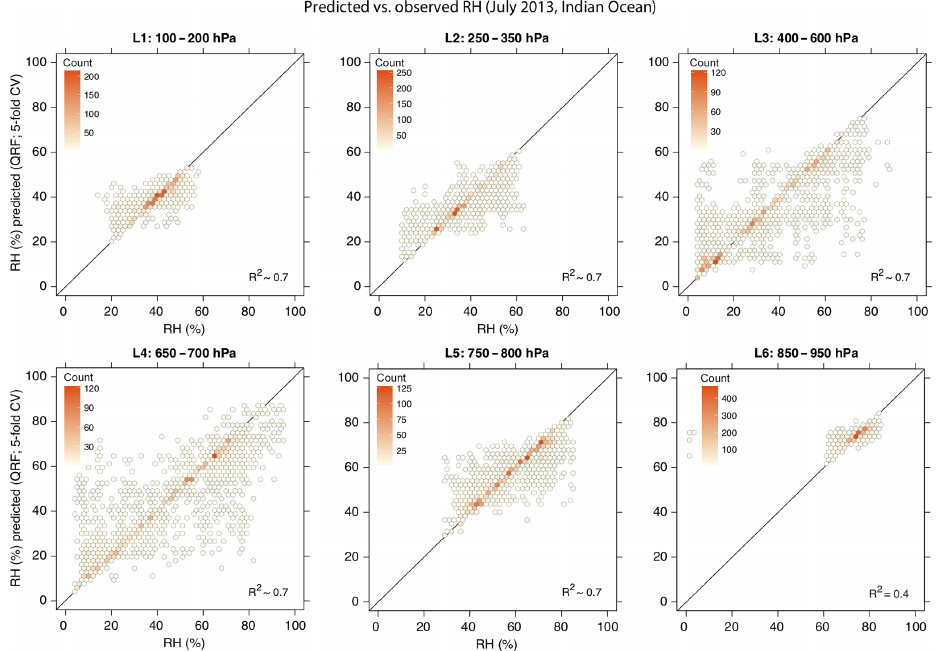
Figure 5. Scatter plot of the median of the predicted distribution vs. observed RH for ice cloud profiles ( k = 8) in the Indian Ocean, July 2013. Predictions are made using the QRF method and are from the validation set within a 5-fold cross-validation scheme. R 2 is (cid:80) − (cid:98) y i ) i ( y i computed as 1 − , where the y i represent SAPHIR observations with mean y and (cid:98) y i are the cross-validation (cid:80) − y ) 2 i ( y i